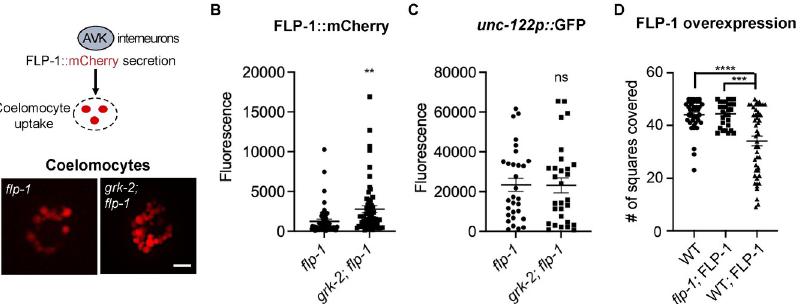
Fig 8. grk-2 mutant animals expressing FLP-1::mCherry show increased fluorescence in their coelomocytes. (A) (Up) Schematic diagram of the coelomocyte uptake assay used to quantify FLP-1 secretion from AVK interneurons. (Down) Representative images of coelomocytes of flp-1(ok2811) and grk-2(gk268); flp-1(ok2811) mutant animals expressing a rescuing construct of FLP-1::mCherry (FLP-1::mCherry; transgene yakEx256 ). Scale bars = 10 μ m. (B)